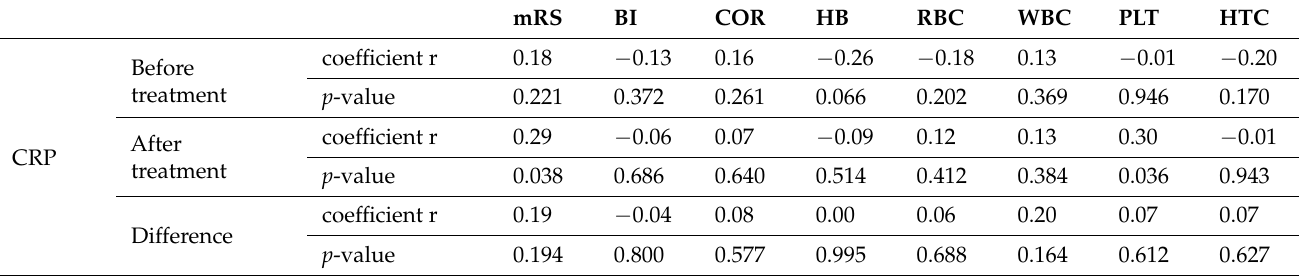
Table 4. Correlations between CRP levels and other